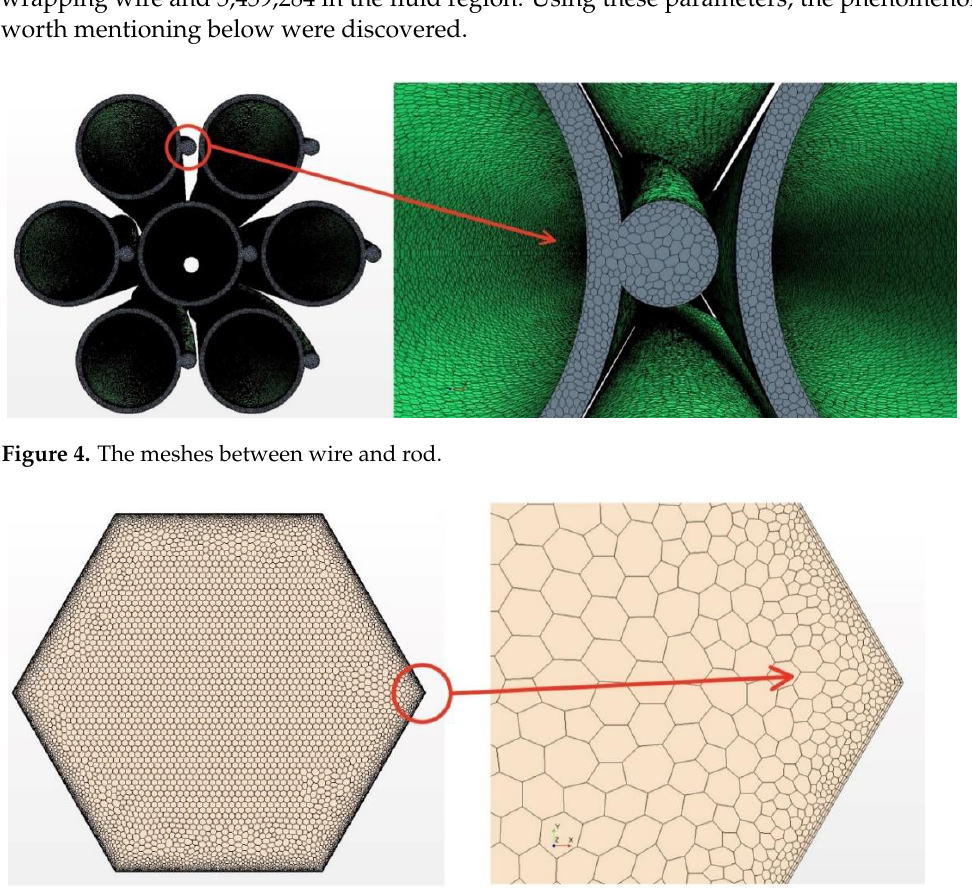
Figure 5. The meshes of inlet section and the